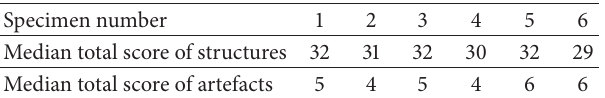
Figure 1: Normal representative images of transverse scans of direct CT (scan 1), and CT tenography (scan 2) of ex vivo forelimb of horses. (a) Proximal pouch of DFTS synovial cavity, (b) SDFT, (b1) manica flexoria, and (c) DDFT. Table 1: Median of total scores assigned by observers for normal structures and artefacts for each